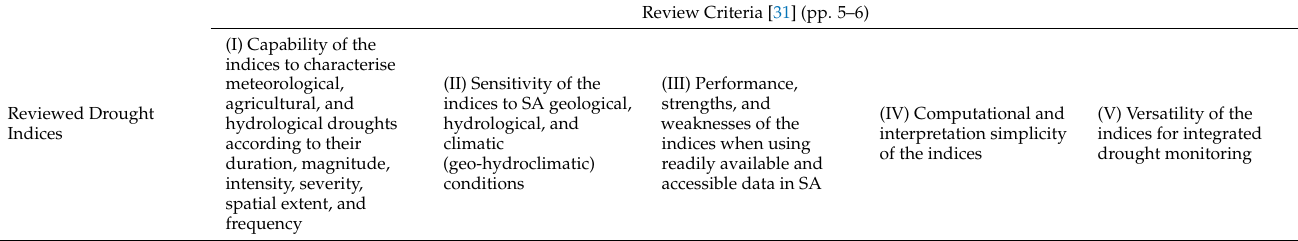
Table 2. Review of the VCI; based on the 2016 WMO Handbook of Drought Indicators and Indices [31] (pp.